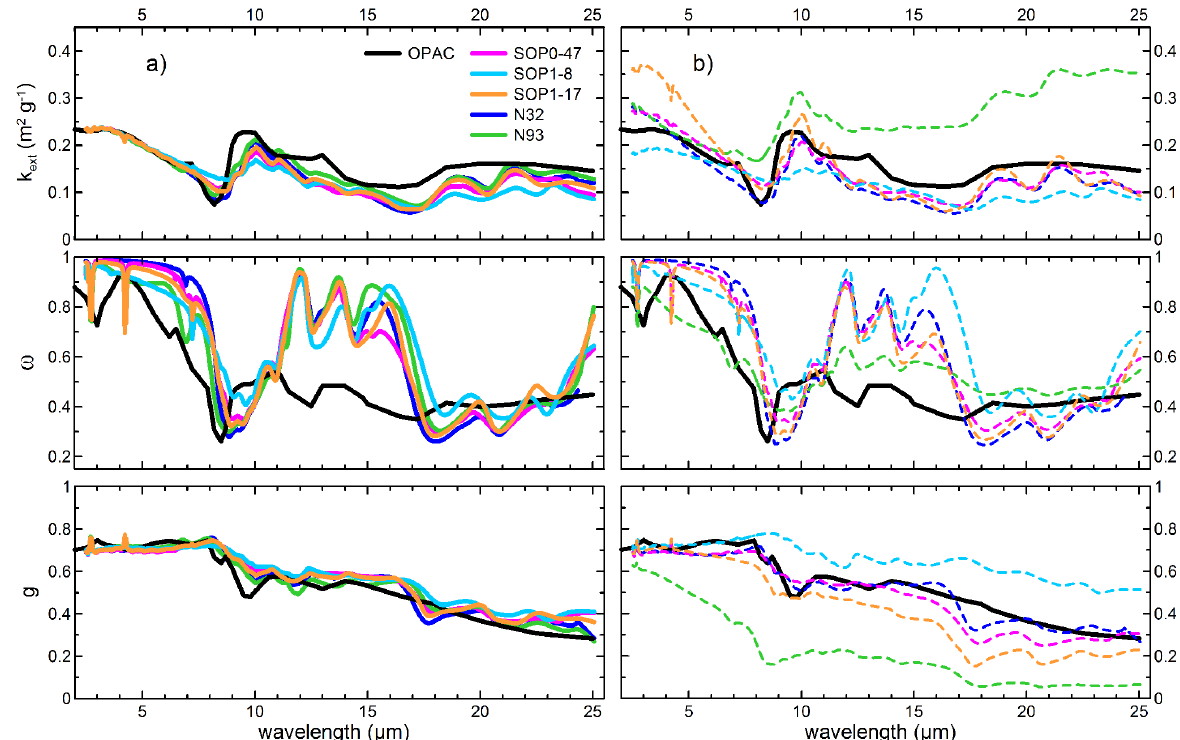
Figure 8. Mass extinction efficiency ( k ext , m 2 g − 1 ) , single scattering albedo ( ω) , and asymmetry factor ( g ) computed with the Mie theory between 2.5 and 25µm for the five analysed dust cases. Calculations have been performed by considering for each sample the estimated refractive index and (a) the same size distribution for the five cases, i.e. the mean_B reported in Fig. 1, or (b) the own size distribution measured in correspondence of each sample. By comparison, the spectral optical properties obtained using the OPAC refractive index, calculated considering the mean_B size distribution, are shown in the plot. The legend in the top left panel identifies the line styles used in the